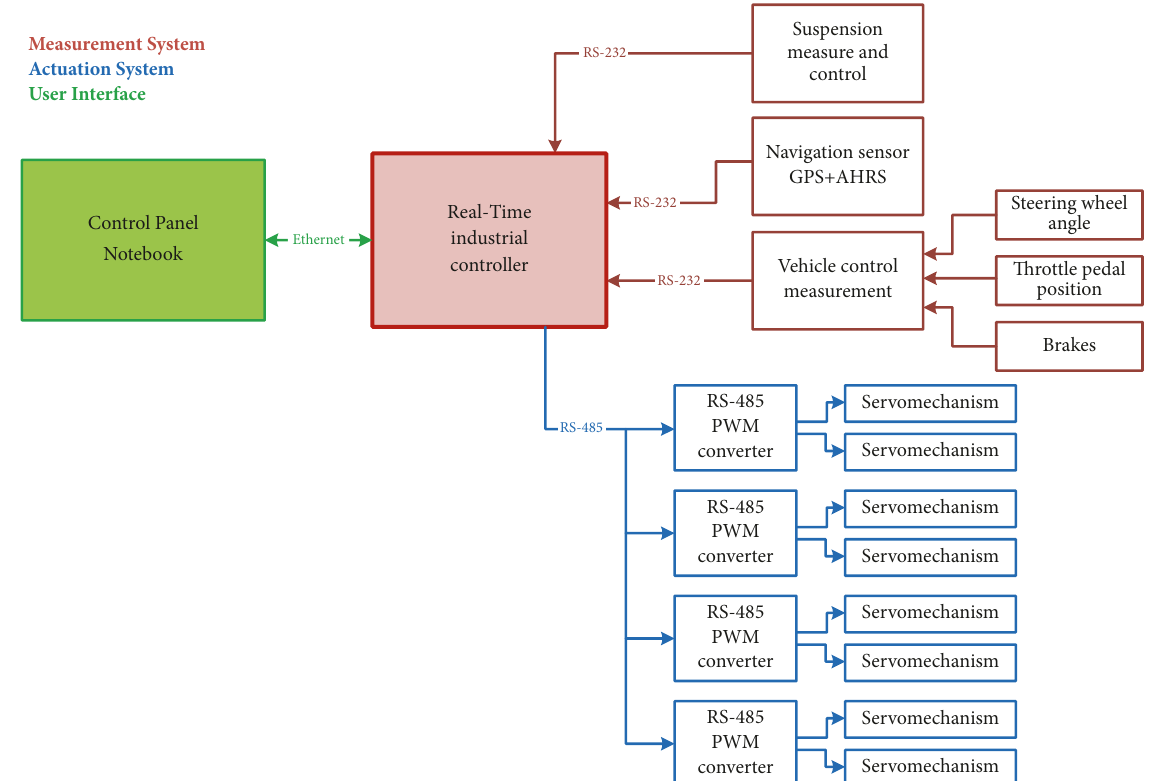
Figure 2: Hardware architecture of the measurement and control system.